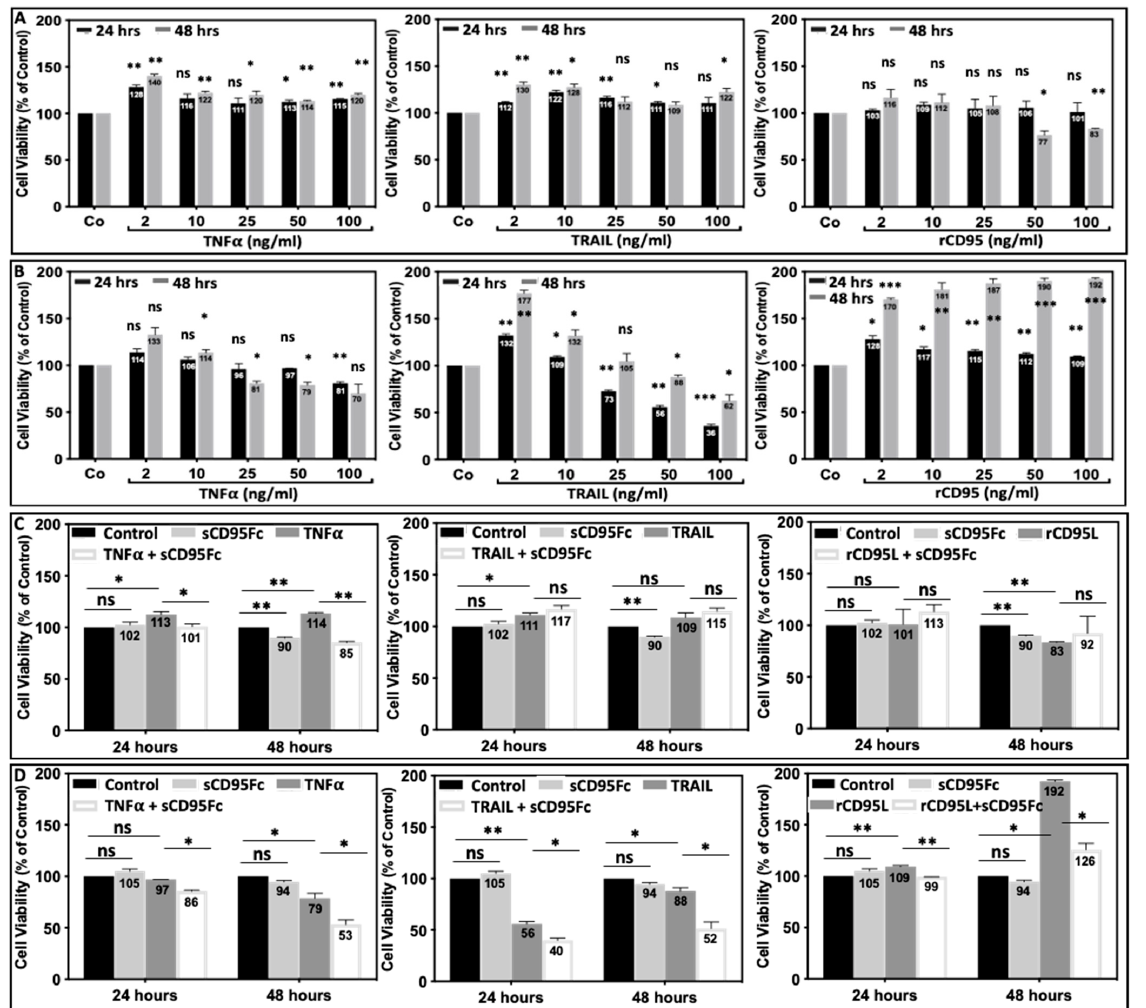
Figure 4. Death ligands (TNF- α , TRAIL, CD95L) affect pancreatic tumor cell growth. Human pancreatic adenocarcinoma cells PancTuI-luc ( A , C ) and A818-4 ( B , D ) were seeded in 96-well plates at a density of 1.0 × 10 4 or 0.7 × 10 4 for treatments of 24 h and 48 h, respectively and were grown in standard cell culture medium. After a 24 h incubation the medium was replaced with fresh medium (100 μ L/well) with escalating amount (2, 10, 25, 50, 100 ng/mL) of TNF- α , TRAIL and recom- binant (r)CD95L ( A , B ) or TNF- α ± sCD95Fc (60 μ g/mL) or TRAIL ± sCD95Fc (60 μ g/mL) or rCD95L ± sCD95Fc (60 μ g/mL) ( C , D ) for 24 h and 48 h. The effect of death ligands on cell proliferation was analyzed by WST-1 proliferation assays and is depicted as cell viability. The absorbance was measured at 460 nm in microplate reader and was calculated as percent of controls (untreated cells). Statistical analysis (Student’s t -test) was performed comparing controls vs. sCD95Fc or TNF- α /TRAIL/rCD95L and TNF- α /TRAIL/rCD95L vs TNF- α /TRAIL/rCD95L +sCD95Fc. Each bar represents the mean of two independent experiments ( n = 2) with four parallel determinations each, error bars indicate the corresponding SDs. Aster- isks indicate statistical significance levels (* p < 0.05; ** p < 0.01; *** p < 0.001; ns, not significant). 3.5. Effect of CD95L Inhibition on the Expression of CD95 and CD95L Induced upon TNF- α , TRAIL and rCD95L Stimulation CD95 and CD95L as transmembrane proteins are key molecules of this crosstalk study. Therefore, we investigated the impact of TNF- α , or TRAIL, or rCD95L signaling on the expression of CD95 and CD95L expression in the presence or absence of the CD95L inhibitor sCD95Fc (Figure 5). We found that rCD95L (100 ng/mL) stimulation elevates the expression of both CD95 and CD95L in PancTuI-luc cells (Figure 5A right). Pre-treatment